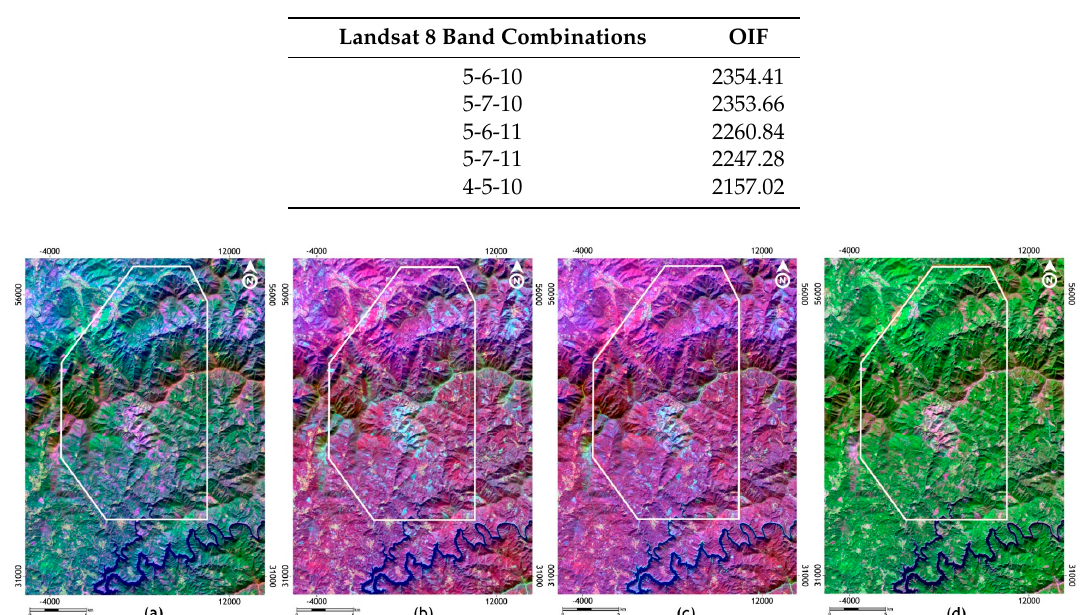
Table 2. Landsat 8 band combinations with the highest OIF values.